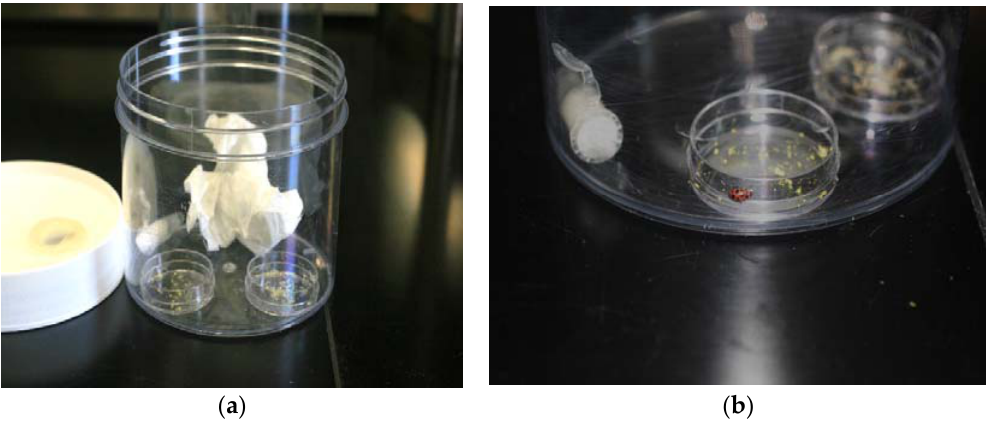
Figure 1. Image of 500 mL cage with chemical dish, food dish, water tube, and tissue substrate inside ( a ) and close ‐ up of C . maculata adult clinging to the outer rim of chemical dish ( b ). Cage dimensions were 7 cm × 11 cm (height, diam). Chemical dish and food dish dimensions were the same, 1.0 cm × 3.5 cm (height, diam). Crumpled tissue paper occupied approximately 20% of the space in the cage.